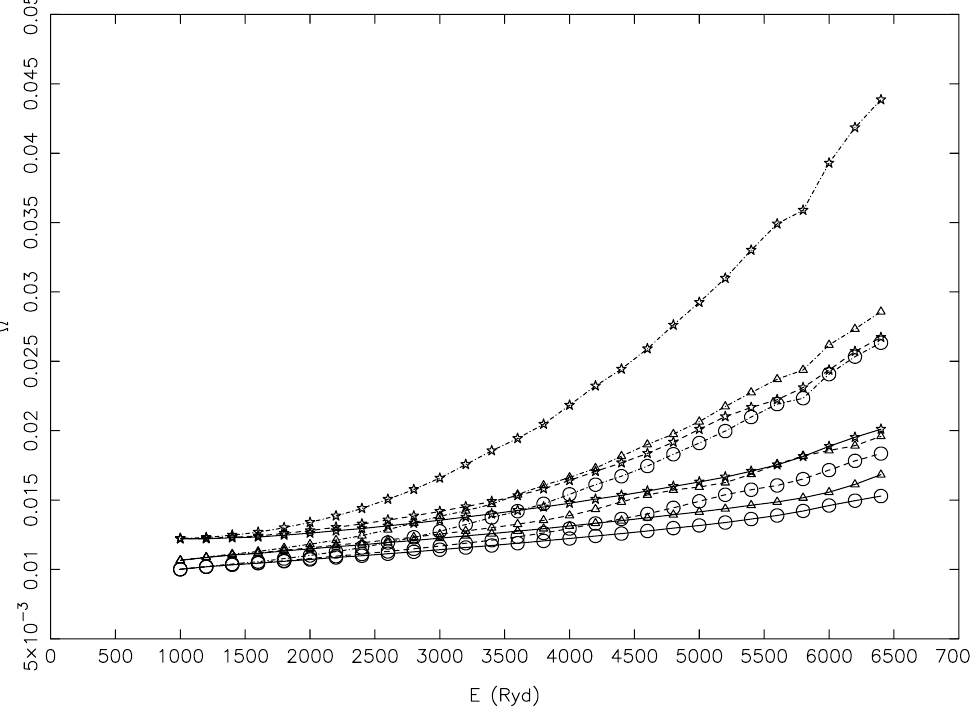
Figure 4. Comparison of collision strengths for the 4–16 (2s 2 2p 4 3s 4 P 5/2 –2s 2 2p 4 3d 4 D 5/2 : circles), 5–18 (2s 2 2p 4 3s 2 P 3/2 –2s 2 2p 4 3d 2 F 7/2 : triangles), and 8–10 (2s 2 2p 4 3p 2 D o transitions of W LXVI. Continuous curves: with top-up at J = 50, broken curves: at J = 40, and dotted curves: at J =